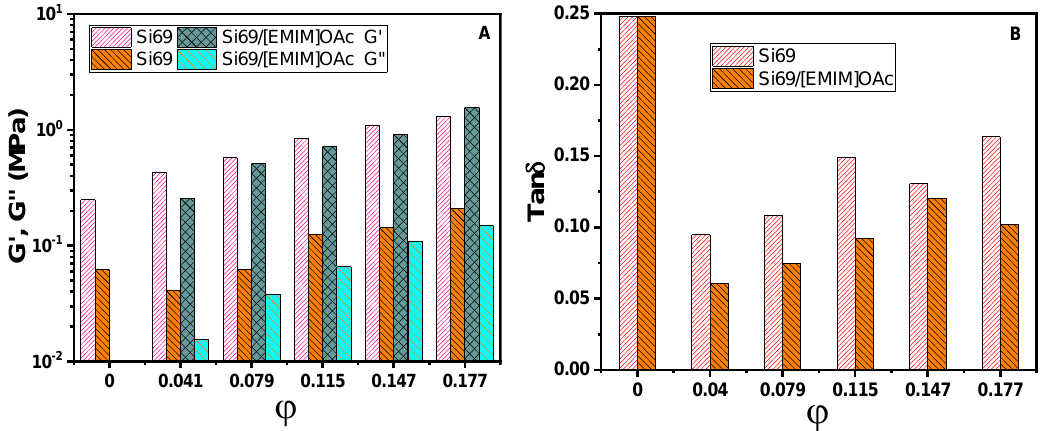
Figure 8. G ’, G ” ( A ) and tan δ ( B ) as a function of ϕ at ω = 120 rad / s and γ = 0.03% for the gum vulcanizate and its Si69–or Si69 / [EMIM]OAc-containing